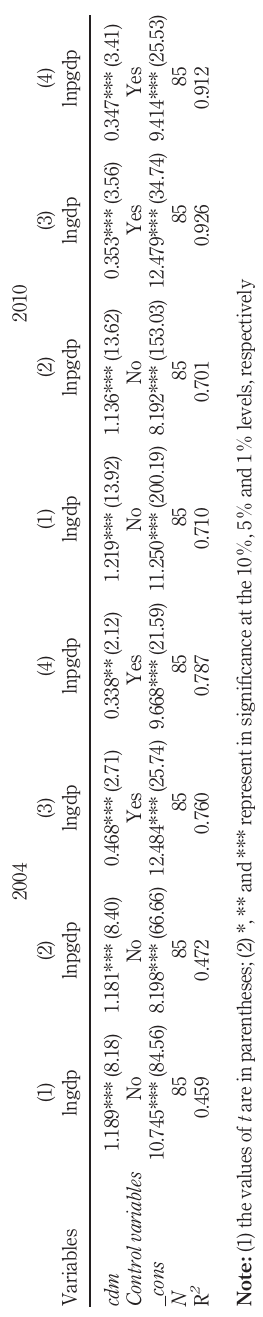
Table 6. Estimation results based on the single- difference